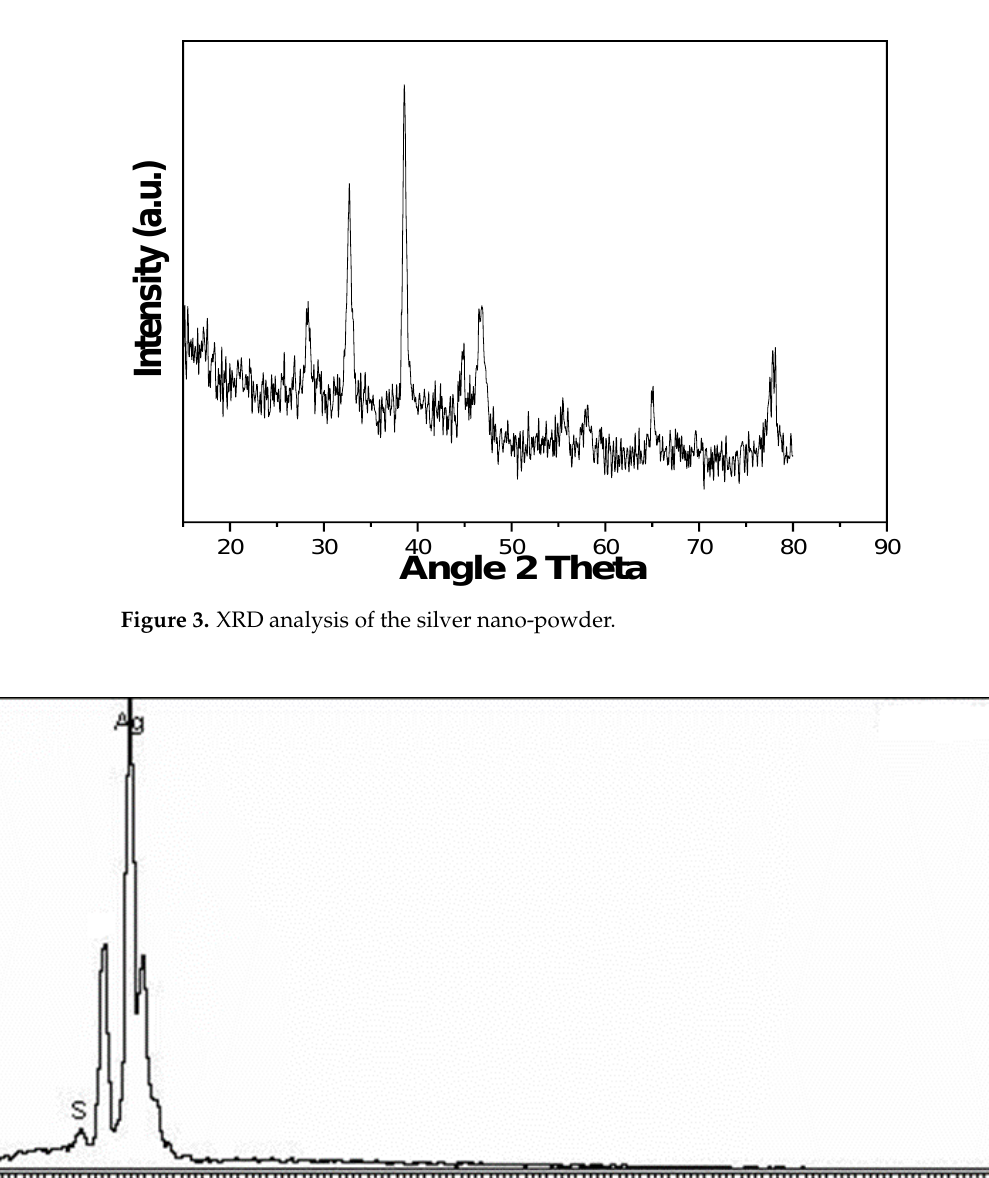
Figure 5. SEM micrographs of the AgNP nanopowders at ( a ) 1 micrometer and ( b ) 0.5 micrometer. 3. Materials and Methods 3.1. Sample Collection Soil samples were collected in sterile and labeled polythene homogenizing containers from an industrial effluent collecting point. The soil samples, contained in homogenized polyethylene bags, were sealed tightly and transported back to the laboratory for the